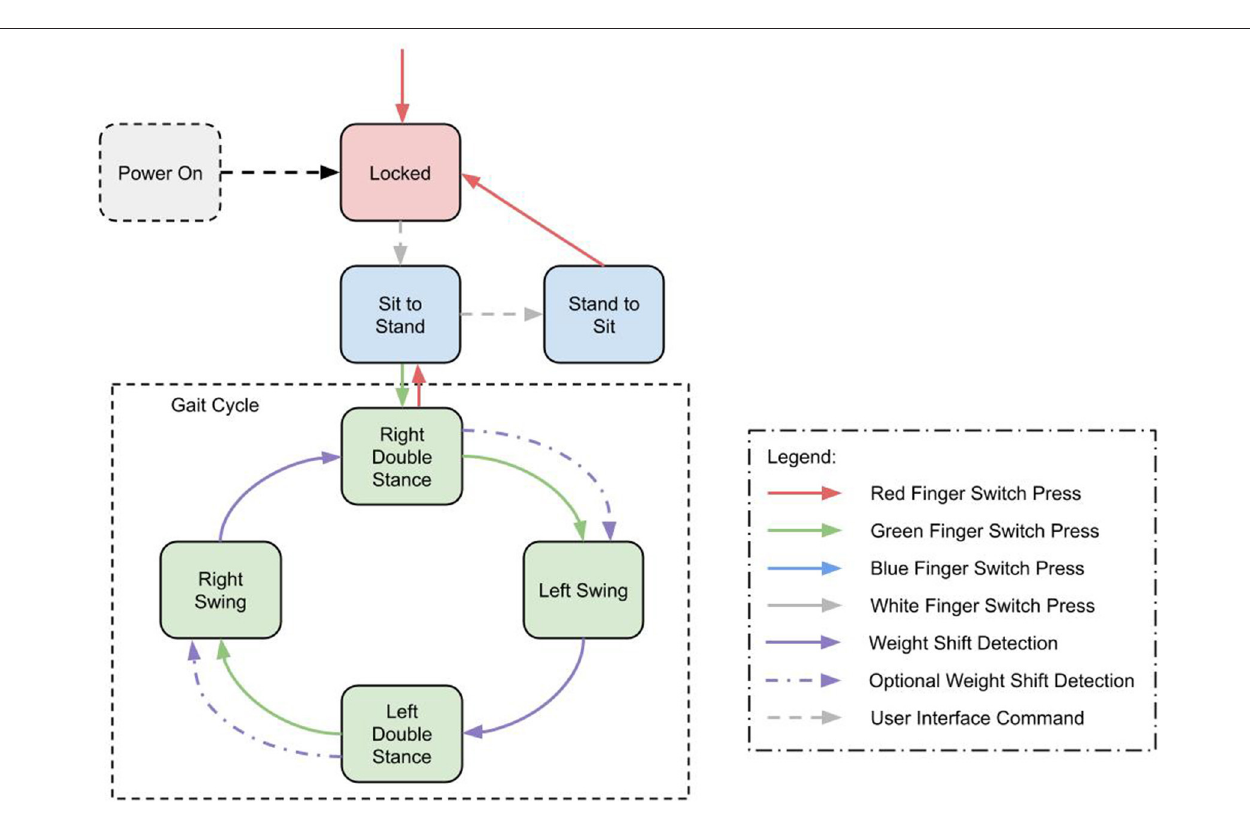
FES system consisting of 16 chronically indwelling intramuscular electrodes Scheiner et al. (1994) that were connected to two stimulation boards on the MAHNP via percutaneous